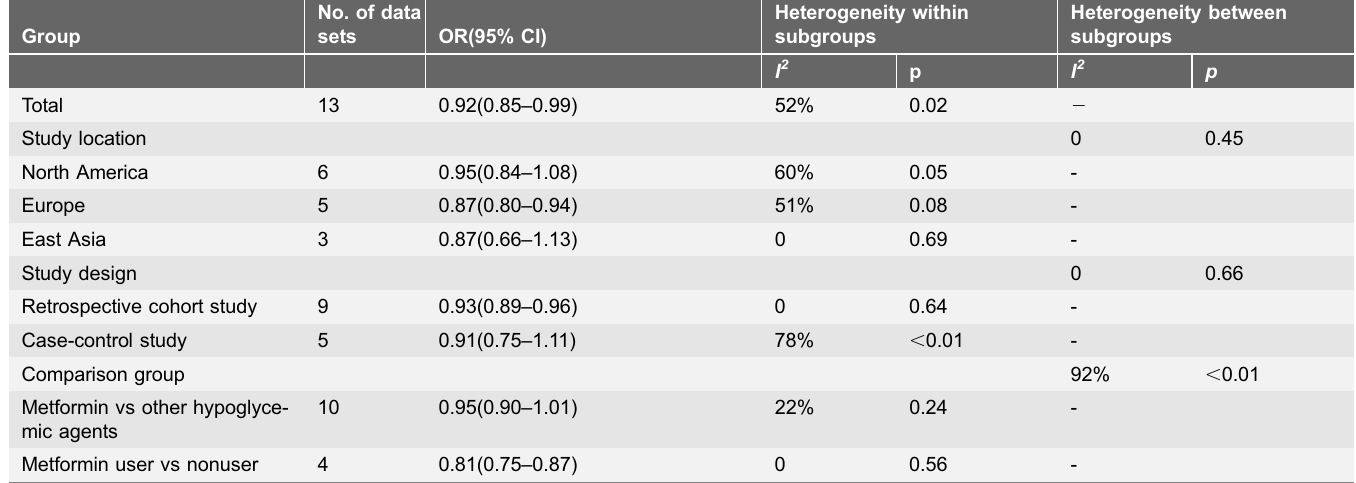
Table 4. Subgroup analysis of the effect of metformin use on the cancer risk of prostate